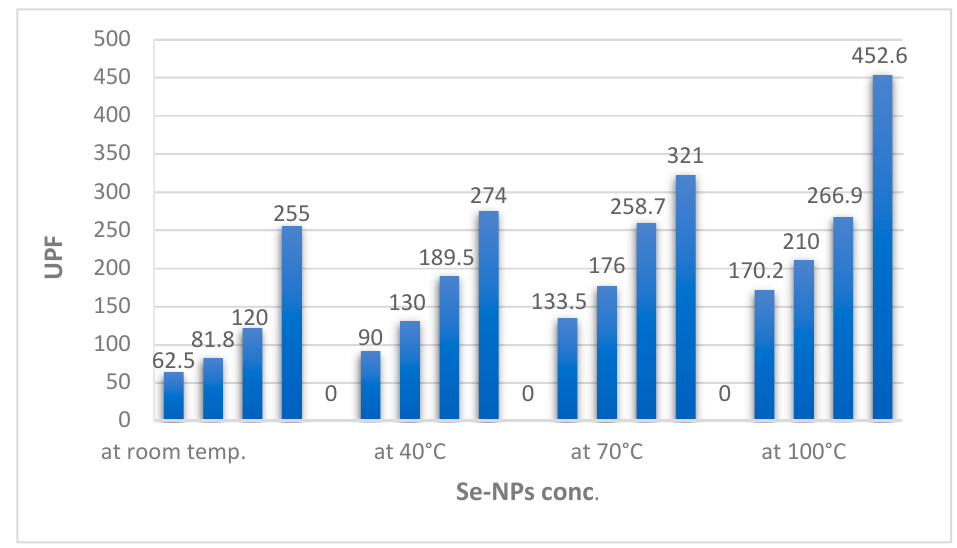
Figure 4. UV protection properties of Se ‐ dyed wool fabrics at different temperatures.